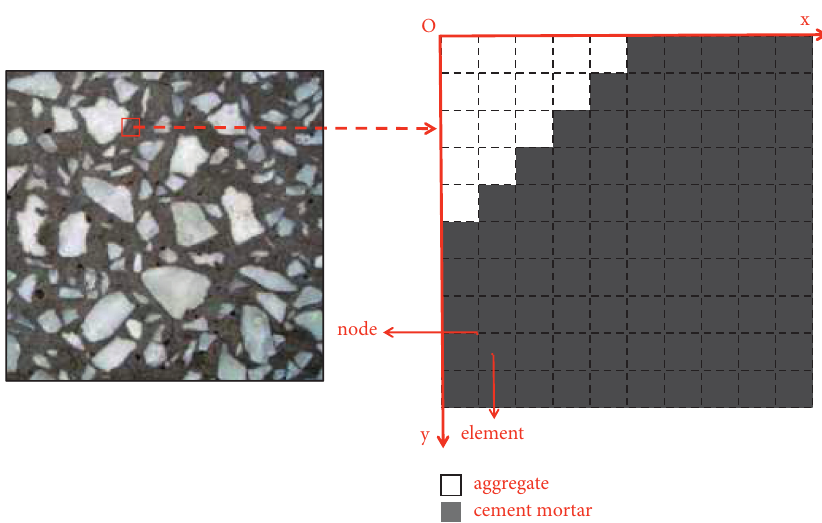
Figure 2: Concrete CT slice and finite element mesh